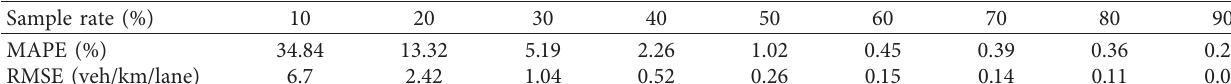
Table 7: MAPE and RMSE comparison of scenario 1 (empirical evaluation).